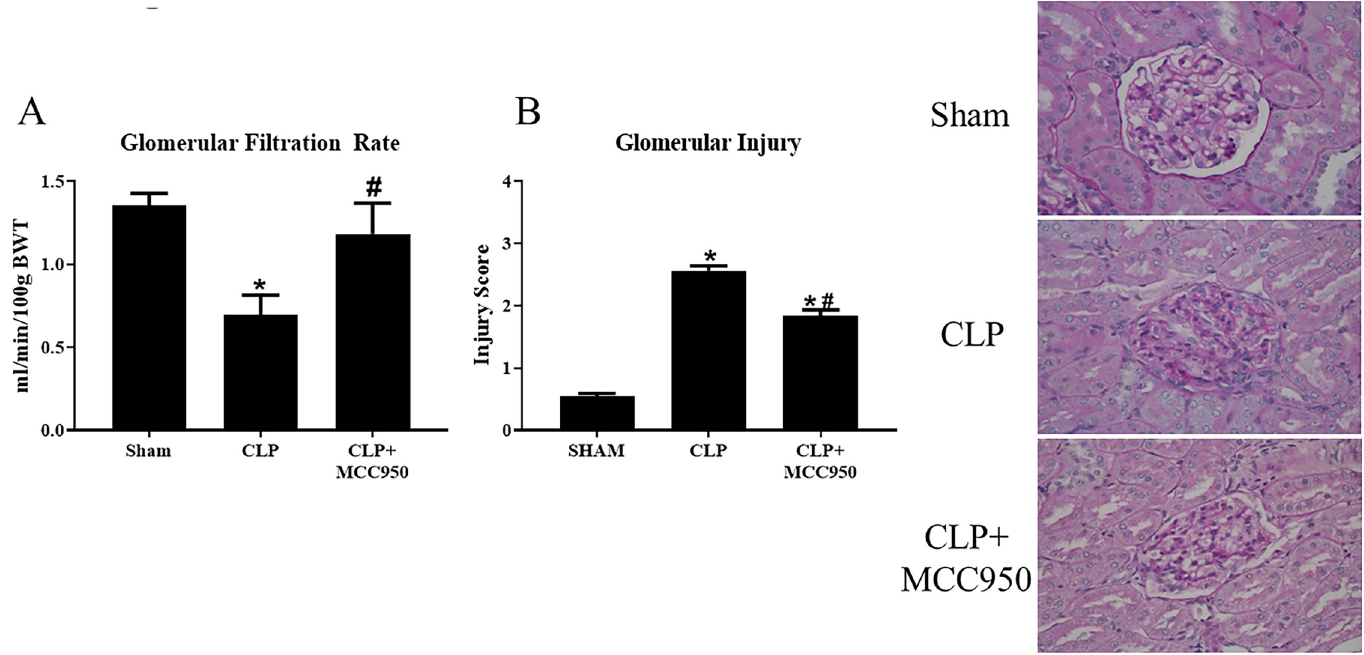
Fig 7. Renal Injury and function. Renal function in response to CLP. Glomerular filtration rate was assessed via FITC sinistrin clearance ( A ).Glomerular injury was assessed after Periodic Acid-Schiff (PAS) staining on paraffin-embedded kidneys from Sham, CLP, and CLP+MCC950 rats ( B ), n = 6 rats (30 glomeruli/rat). � p < 0.05 vs Sham, #p < 0.05 vs